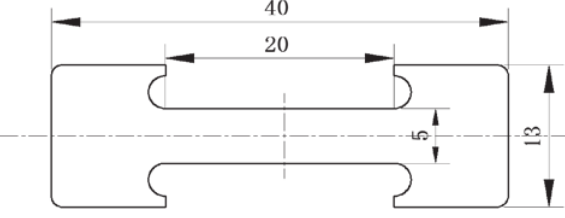
Fig. 1: Dimension of tensile specimens in mm